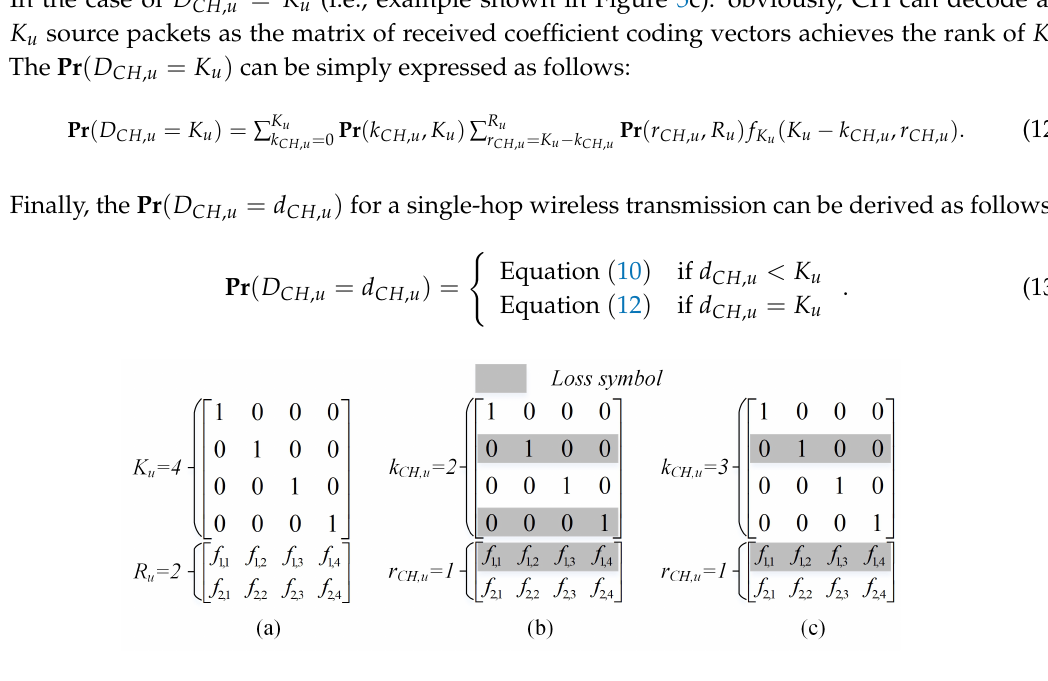
Figure 5. Representative matrix of coefficient coding information at ON and CH; ( a ) ON u ; ( b ) case of D CH , u = 2 < K u = 4; ( c ) case of D CH , u = K u =